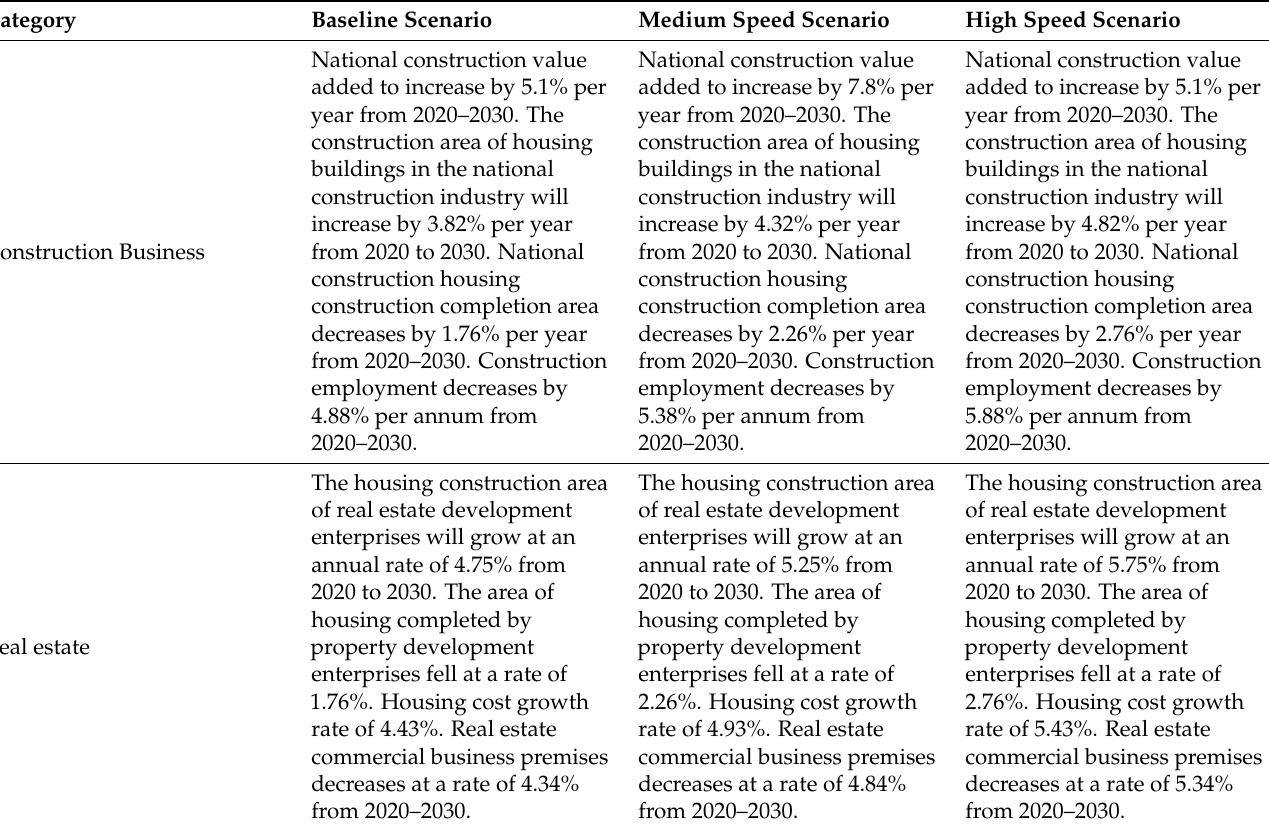
Table 6. Rules for setting influencing factors in different